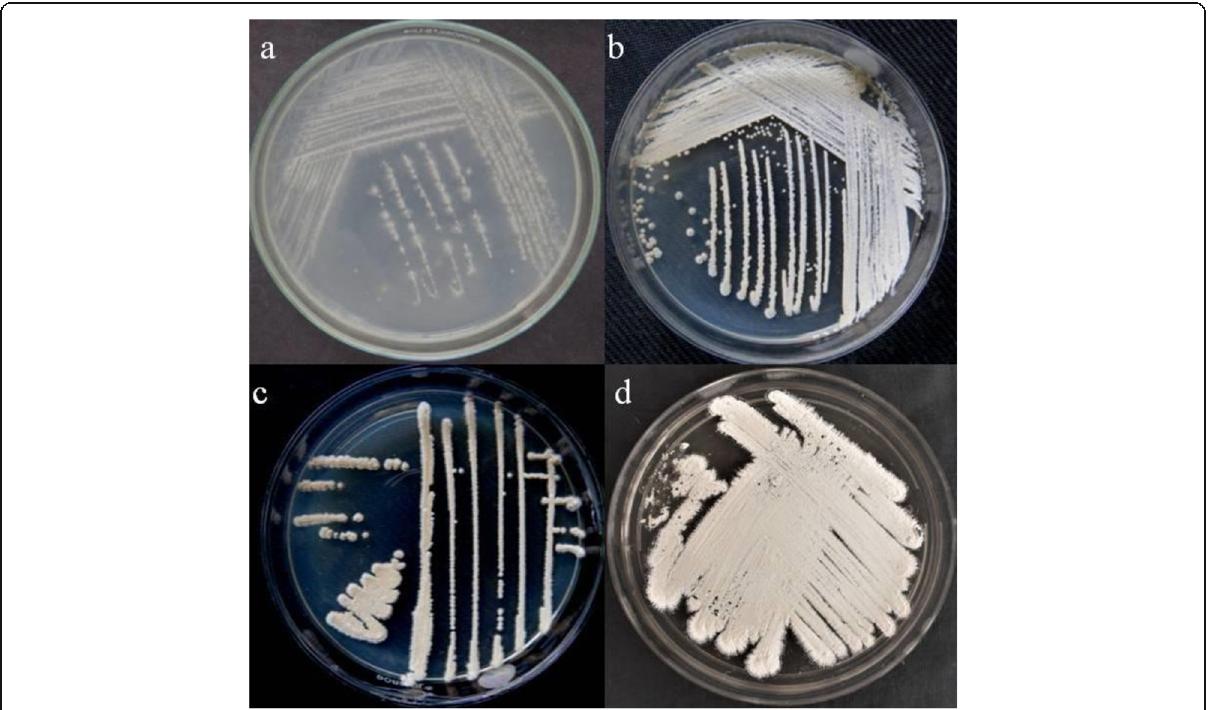
Fig. 1 a Streptomyces sp. MI04. b Streptomyces roietensis MI24. c Streptomyces misionensis MI22. d Streptomyces glaucescens